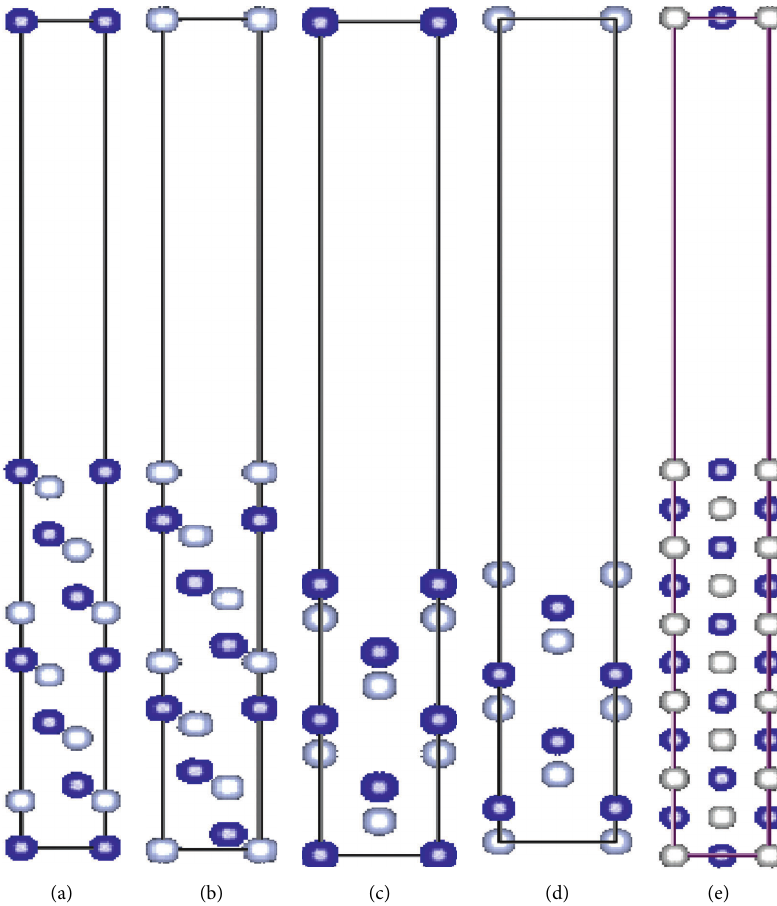
Figure 2: Schematic view of supercells for cBN along the < 001 > axis: (a) (111)-B slab with 13 layers, (b) (111)-N slab with 13 layers, (c) (100)- B slab with 9 layers, (d) (100)-N slab with 9 layers, and (e) (110) slab with 11 layers. The gray and blue spheres represent B and N atoms,